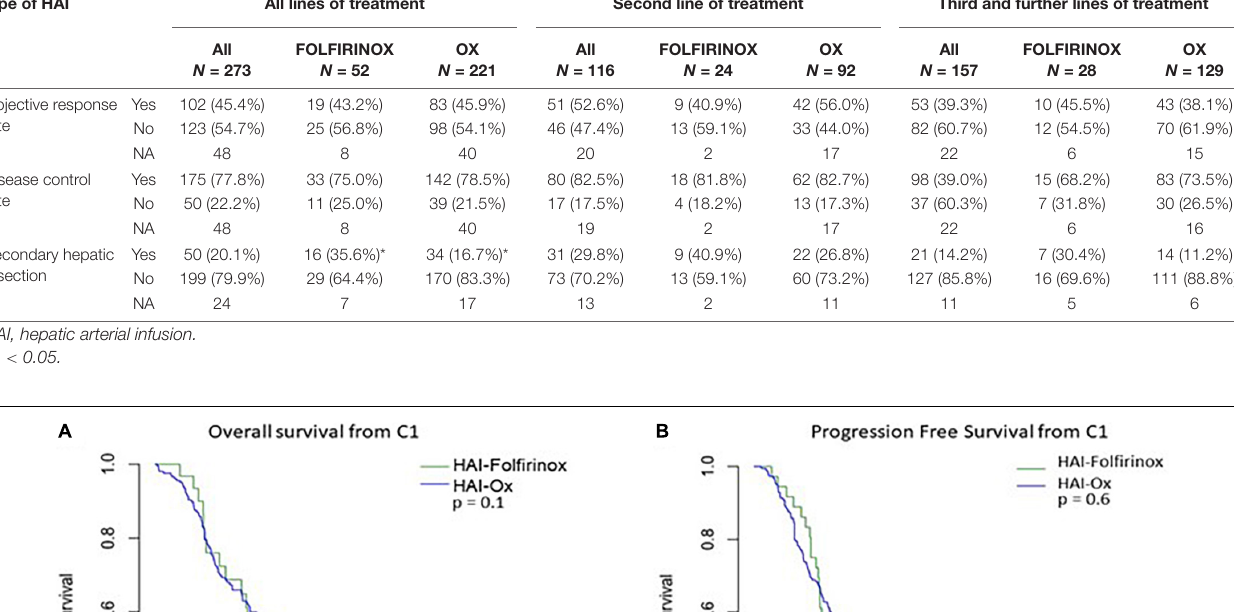
Frontiers in Medicine |